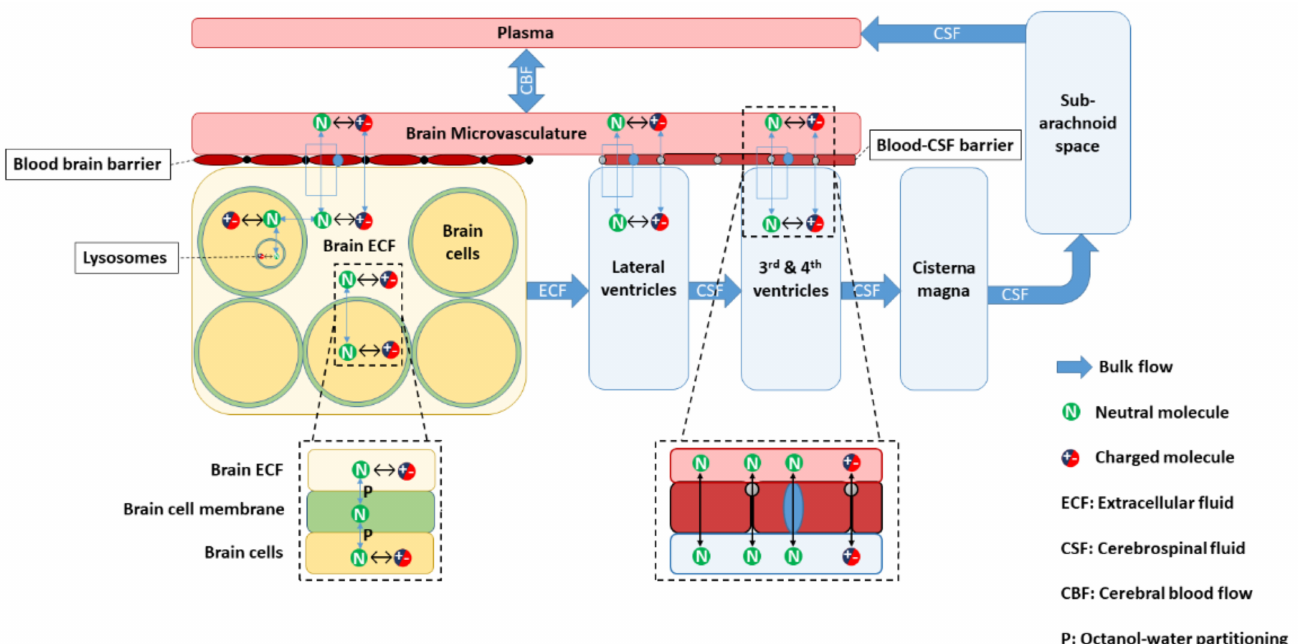
Figure 1. LeiCNS-PK3.0 model structure. The central nervous system (CNS) model connects to the plasma via cerebral blood flow. LeiCNS-PK3.0 accounts for the brain and cerebrospinal fluid (CSF) compartments, the presence of the blood–brain barrier (BBB) and blood–CSF barriers, drug transport across the barriers and within the CNS, and physiological process such as non-specific binding and the effect of pH on drug ionization and on its passive